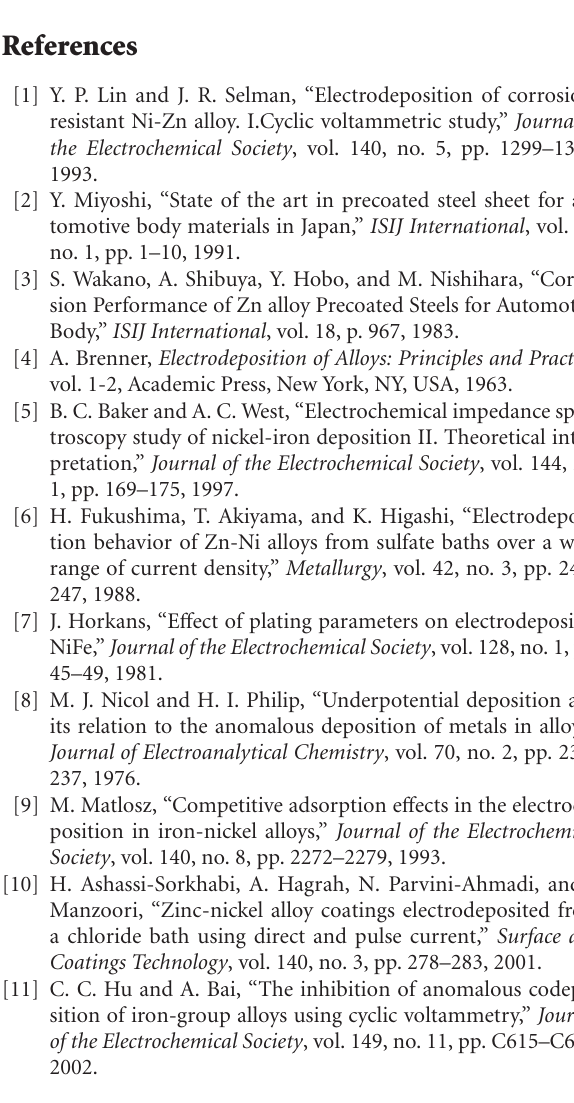
Figure 11: Current e ffi ciency on the molar ratio plotted at 5mA/cm 2 in a solution containing | Na 2 SO 4 | = 0.5